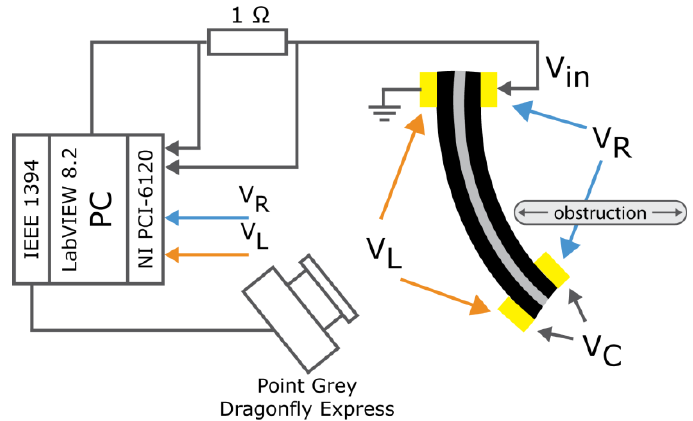
Figure 15. Experimental setup for measuring signals during the work-cycle of a CPC